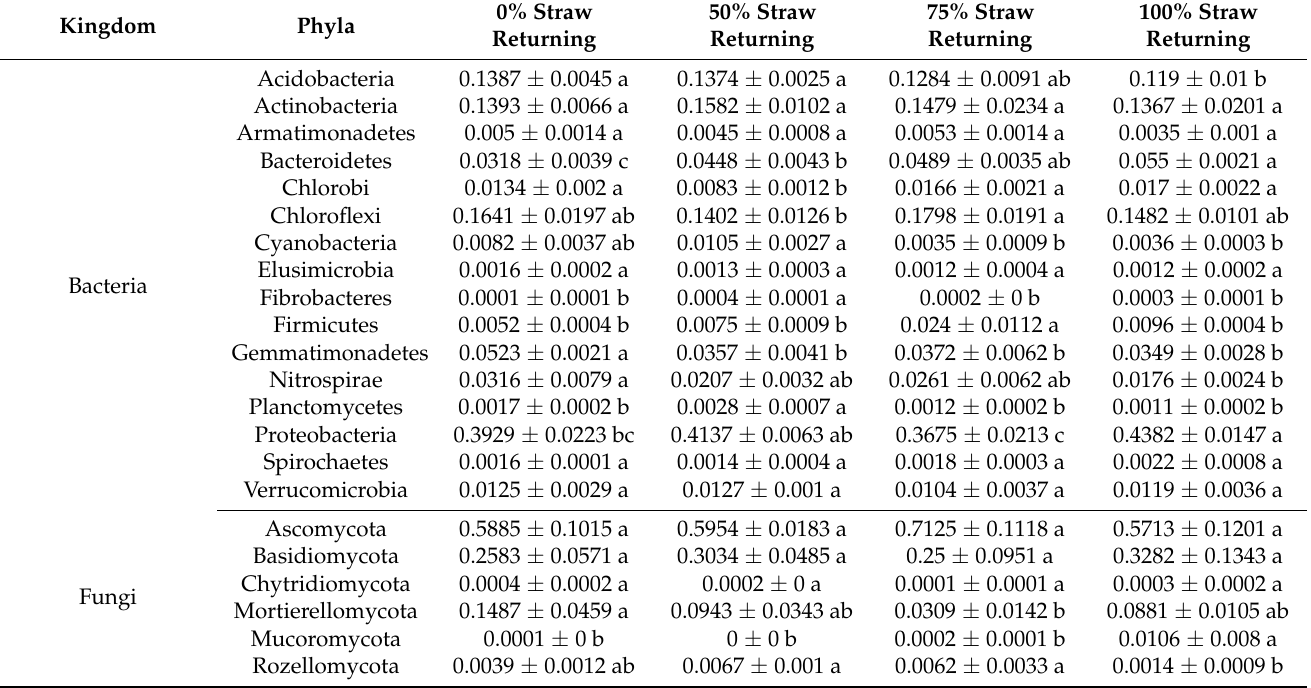
Table 2. Relative abundance of bacteria and fungi at the phylum level in paddy soil with different levels of straw additions.